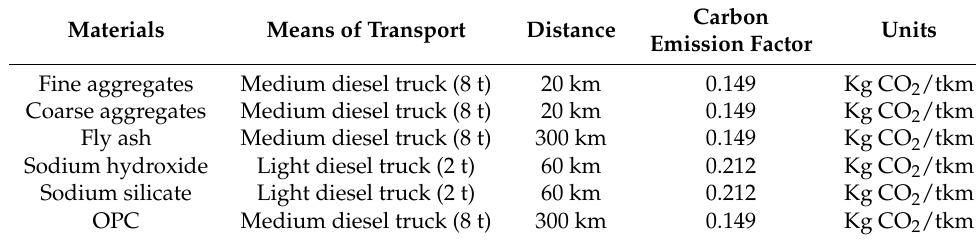
Table 2. Emission factors of